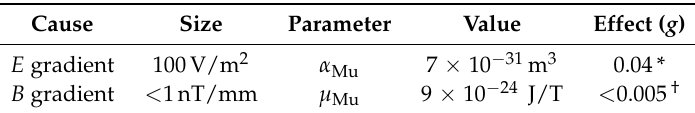
Table 1. Summary of gradient effects on ¯ g